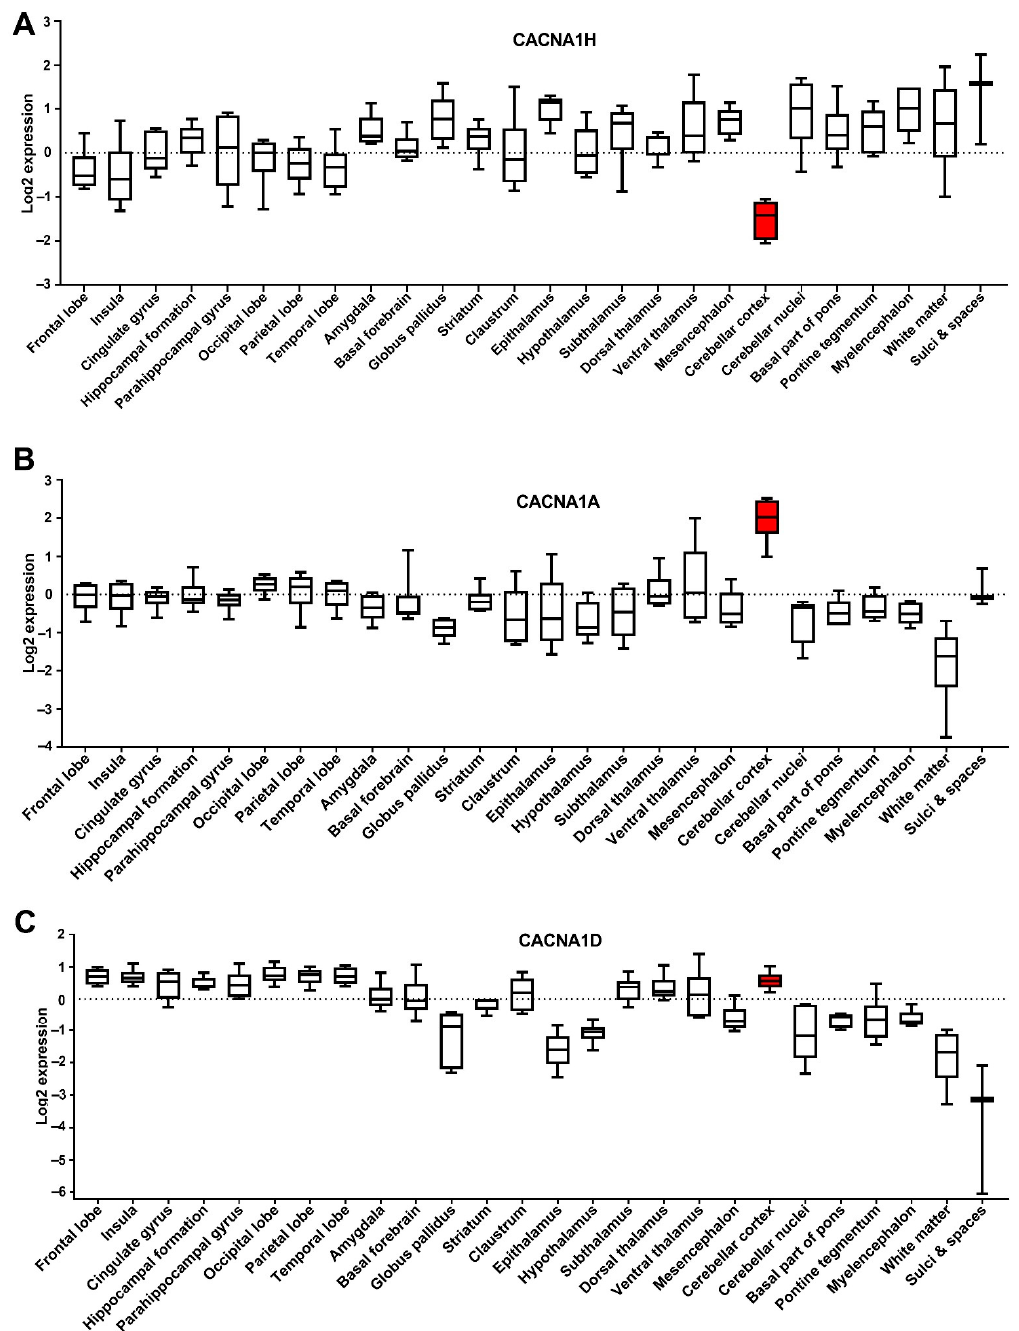
Figure 6. Expression of the CACNA1 genes in different brain sections. Microarray data from 6 brain samples obtained from the Allen Human Brain Atlas dataset, showing the expression of ( A ) CACNA1H, ( B ) CACNA1A and ( C ) CACNA1D in log2. Box and Whiskers plot (whiskers indicate min to max) is shown. Cerebellar cortex box is highlighted in